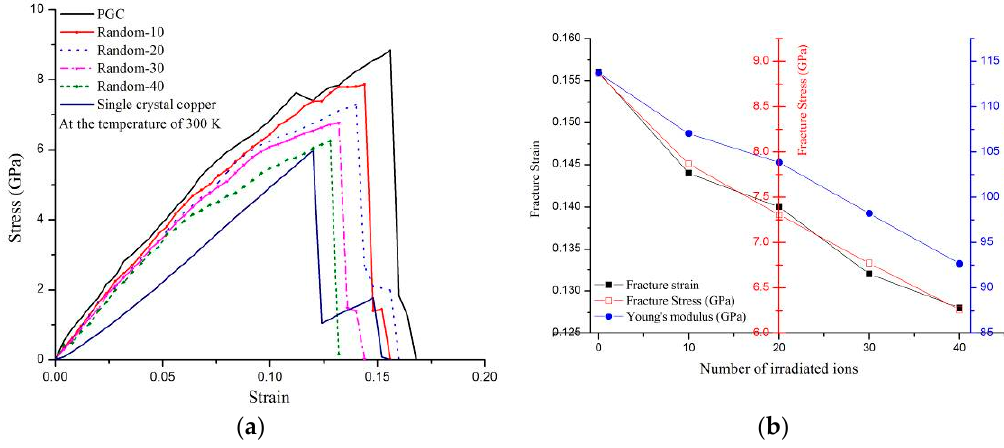
Figure 3. Mechanical properties of graphene/copper layered composites. ( a ) Stress-strain curves and ( b ) mechanical values of graphene/copper layered composites and single crystal copper (Random − 10, − 20, − 30, and − 40 represent graphene/copper layered composites with various defects, which are created by using 10, 20, 30, and 40 doses of atoms, respectively.).